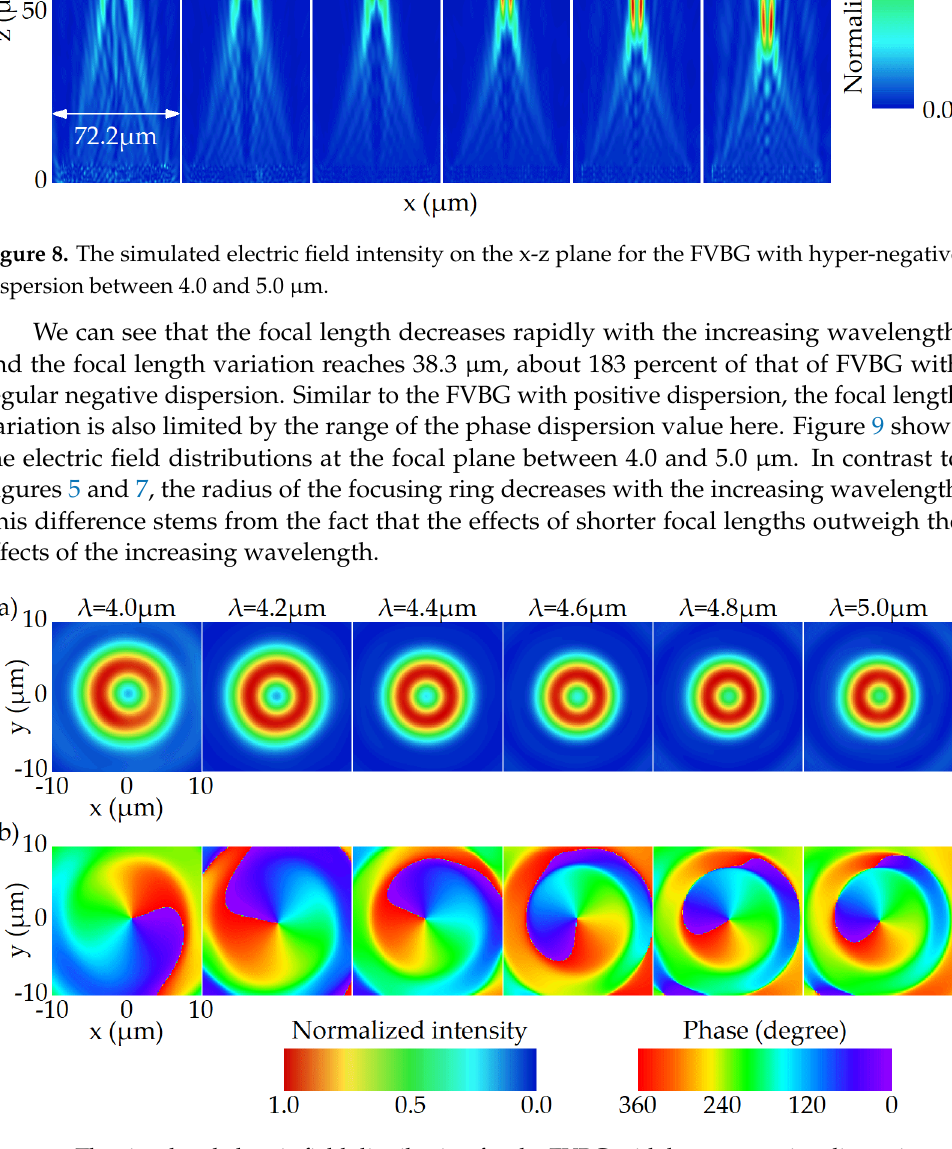
4.4. Hyper-Negative Dispersion